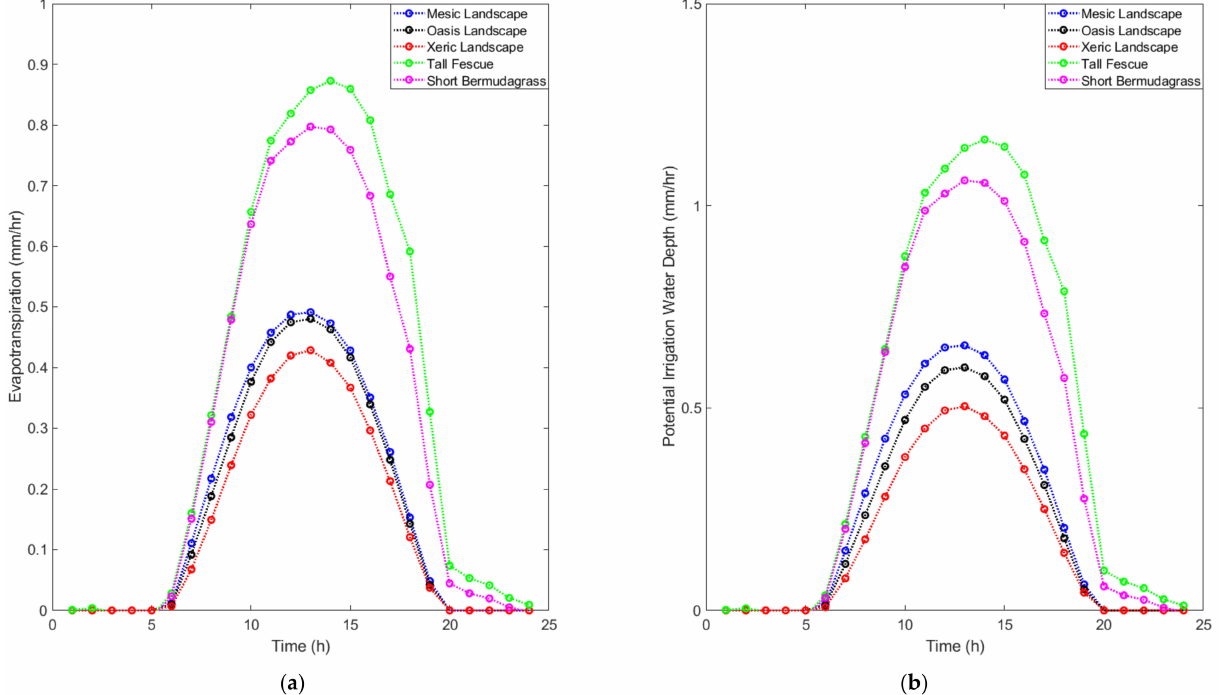
Figure 7. ( a ) Evapotranspiration rates of the landscapes; ( b ) potential irrigation water depths of the